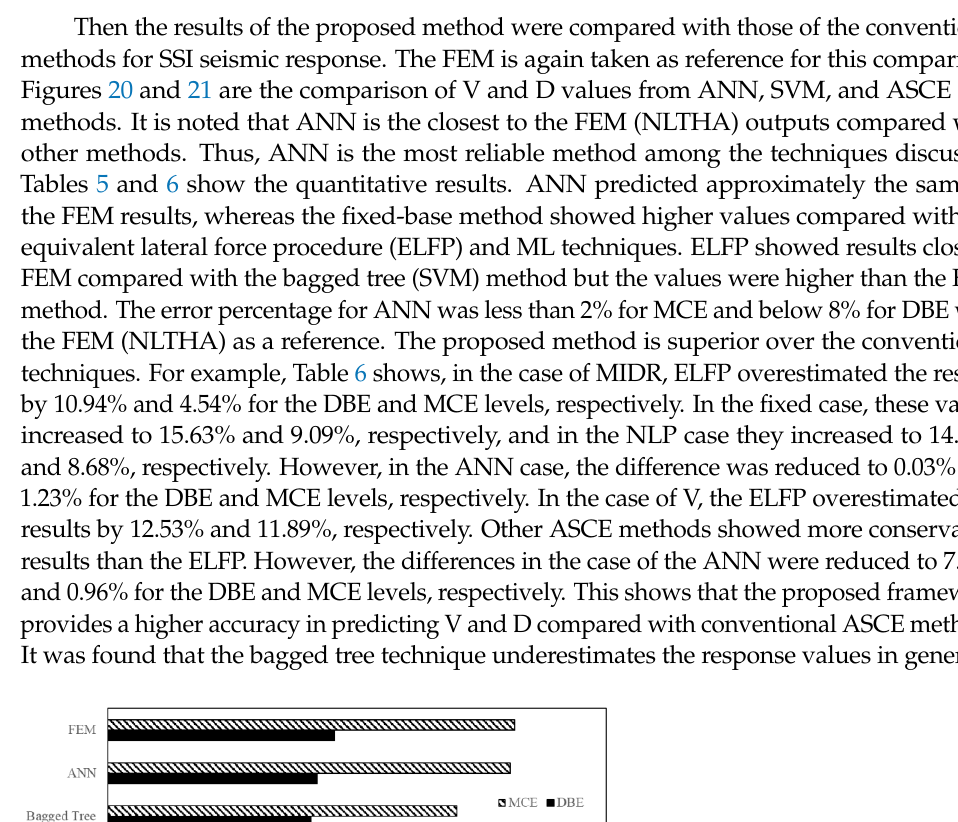
Figure 21. Comparison of MIDR obtained from different techniques. Table 5. Values of the base shear obtained from different techniques for the three-story mass irreg- ularity structure. 10%/50 yr ( DBE ) - * Best technique. Table 6. Values of MIDR obtained from different techniques for the three-story mass irregularity structure.